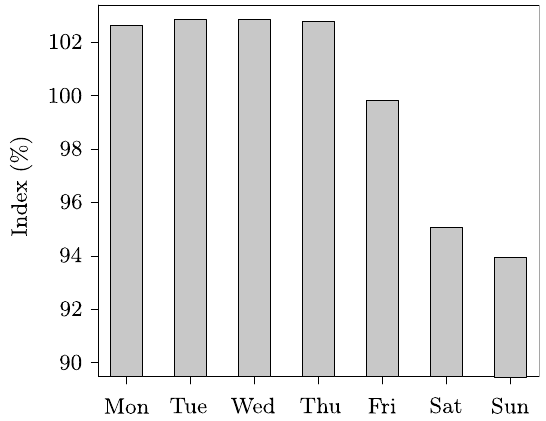
Figure 1: Weekly seasonal index plot of